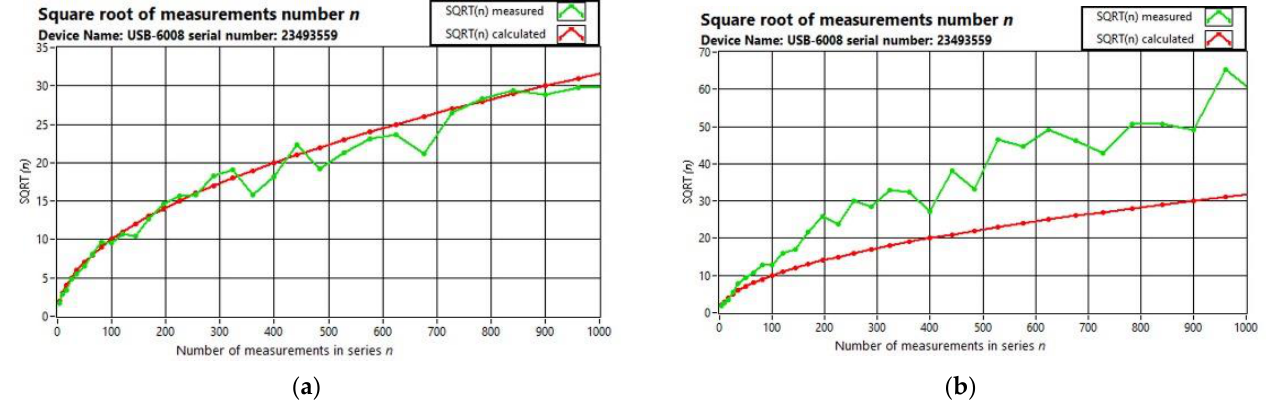
Figure 13. The ratio of the experimental standard deviation in a single result in a series to the experi- mental deviation of the mean value of a series of n measurements compared to the root of the number of measurements for the tested module NI USB-6008: ( a ) at low interference level, ( b ) at high interference level.